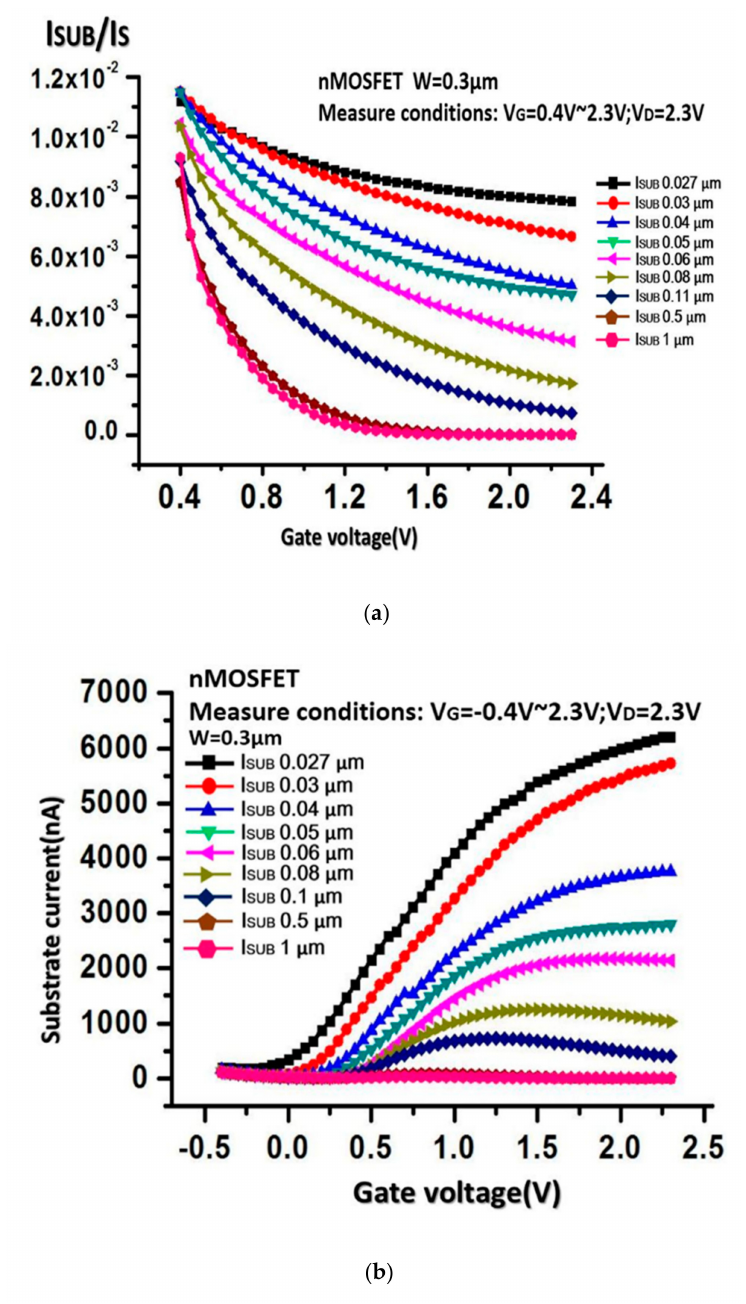
Figure 4. ( a ) The impact ionization compared with di ff erent channel lengths; ( b ) substrate current with di ff erent channel lengths of